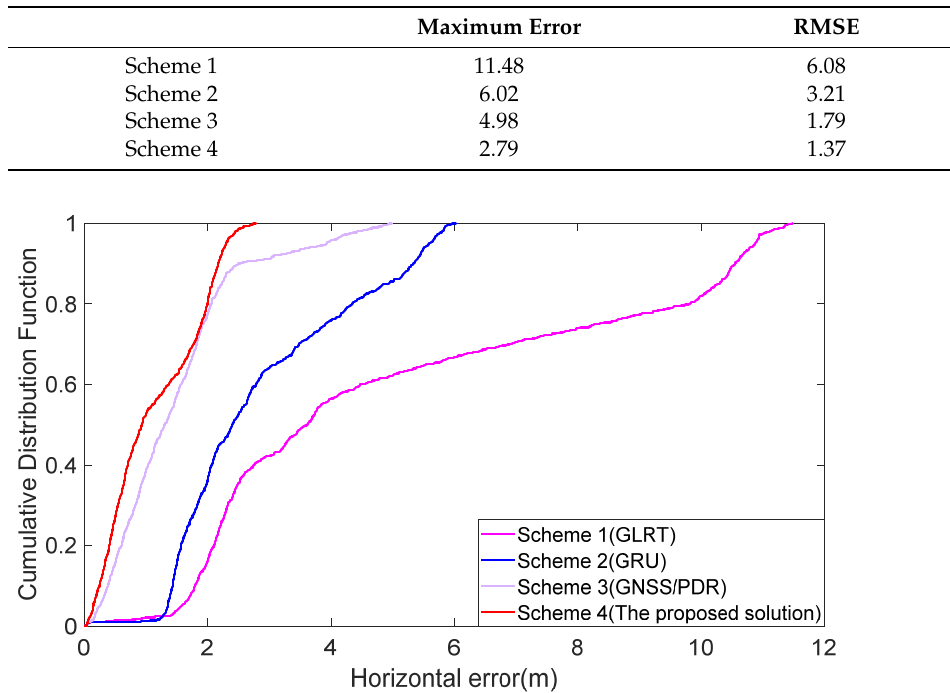
Figure 14. CDF of horizontal error obtained by different schemes.